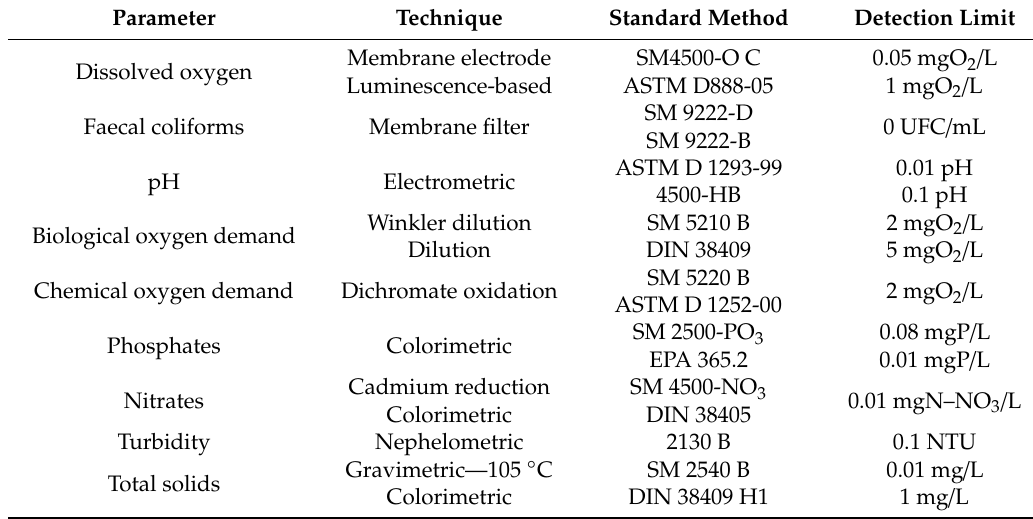
Table 1. Summary of laboratory techniques, standard methods used, and detection limits for determination of di ff erent parameters.